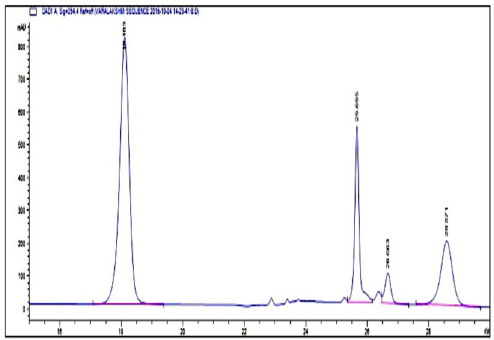
Fig. 4. Regression equation and correlation coefficient of standard curves of dansylated BAs